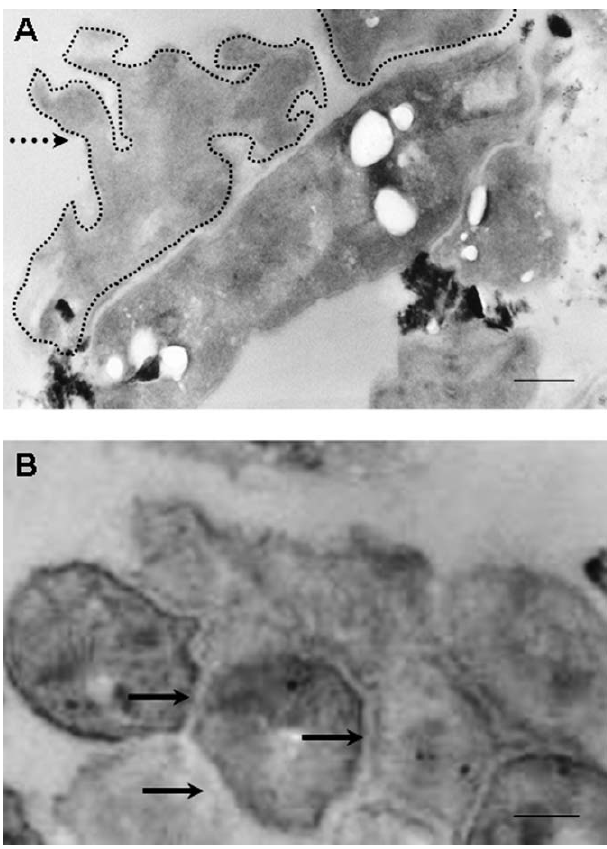
Figure 2. M. ulcerans ECM Localized Only in the Outermost Bacterial Layer Transmission electron micrographs of cluster formation by M. ulcerans showed that ECM covers only the peripheral bacterial layer. (A) ECM thickness is estimated to range between 4 and 40 l m (dotted line and arrow). (B) Compared to classical biofilm, the space between M. ulcerans bacteria in the cluster is small (arrows), with little ECM. Scale bars: 1 l m.